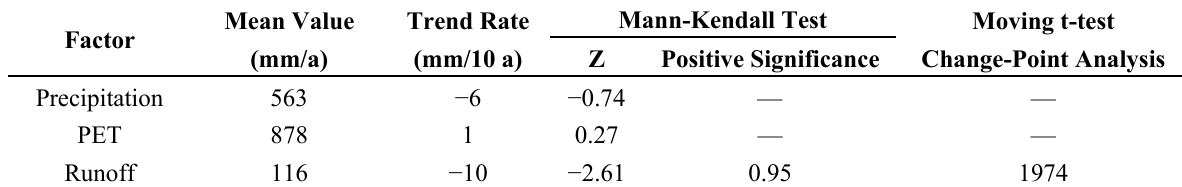
Table 3. Trend and change-point analysis of annual precipitation, potential evapotranspiration (PET) and runoff in the Songhua River Basin, Northeast China. Mean Value Trend Rate Factor (mm/a) (mm/10 a)